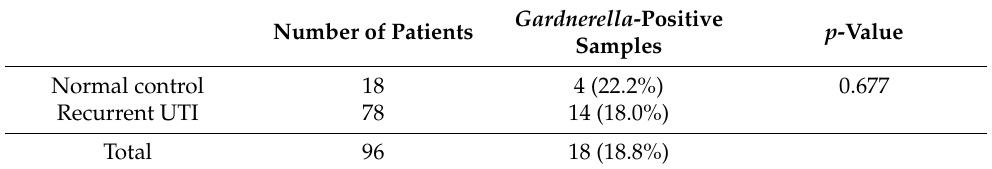
Table 2. Positive detection rate of Gardnerella species.